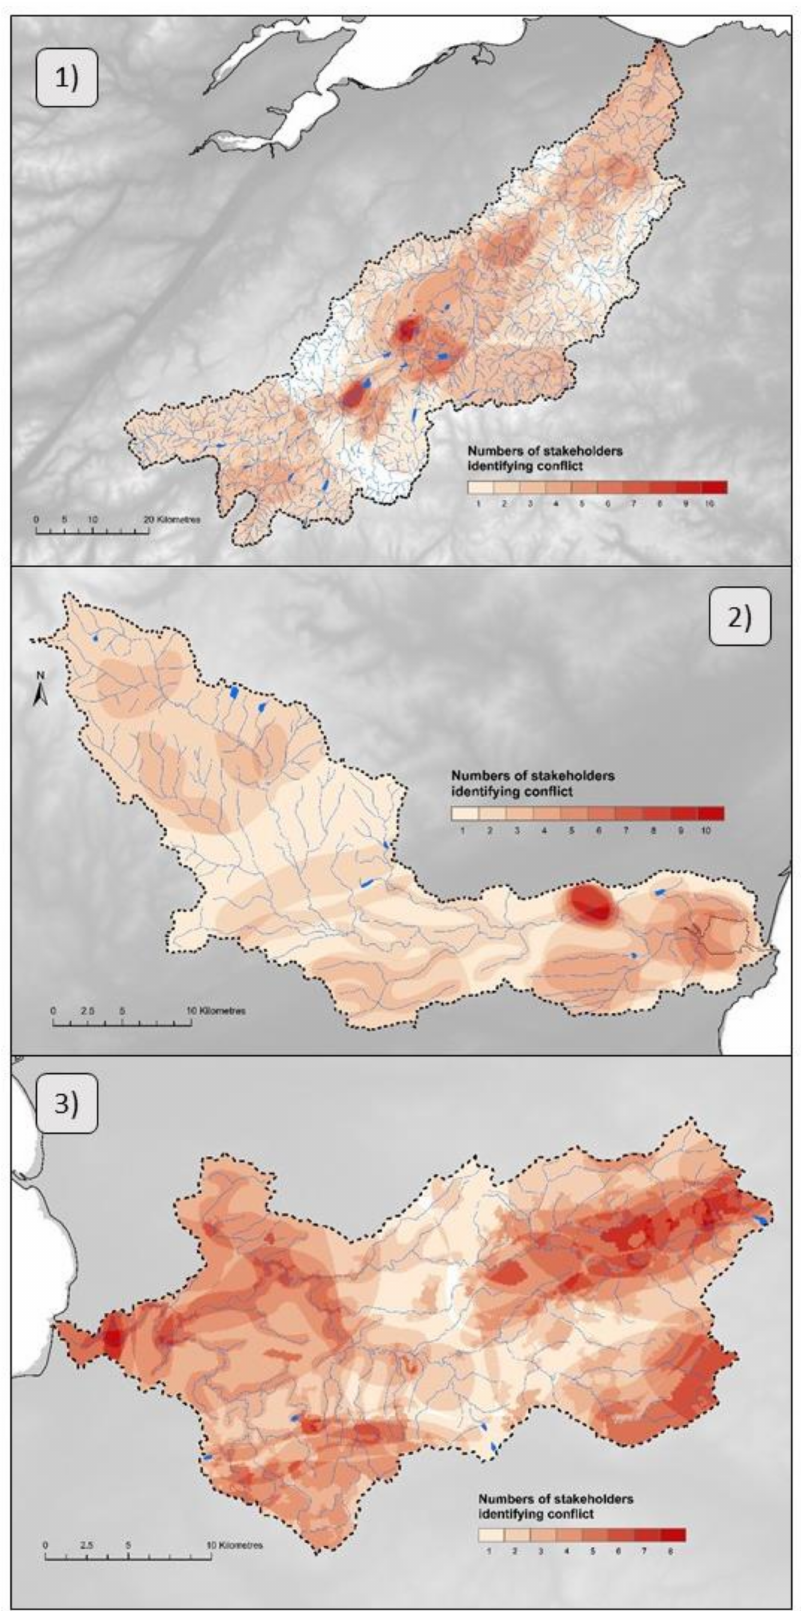
Figure 2. Heat maps of perceived conflict in the River Spey ( 1 ), River South Esk ( 2 ), and River Ayr catchment ( 3